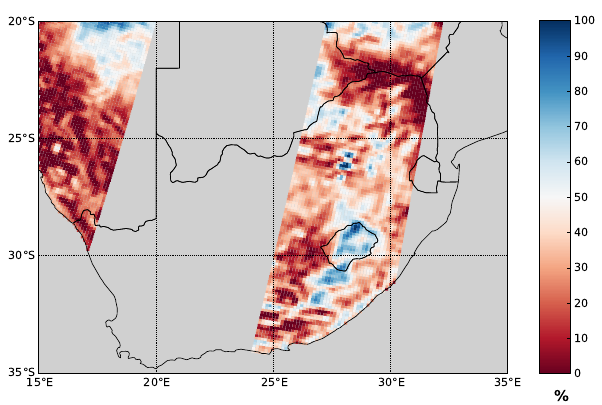
Fig. 11. Locality of the four different areas considered, plotted over Mean Annual Precipitation (MAP) data obtained from WR90 ( Midgley et al., 1994). The general trend is for MAP to increase from West to East. An important exception is the southern coastline, which receives significant winter rainfall associated with frontal